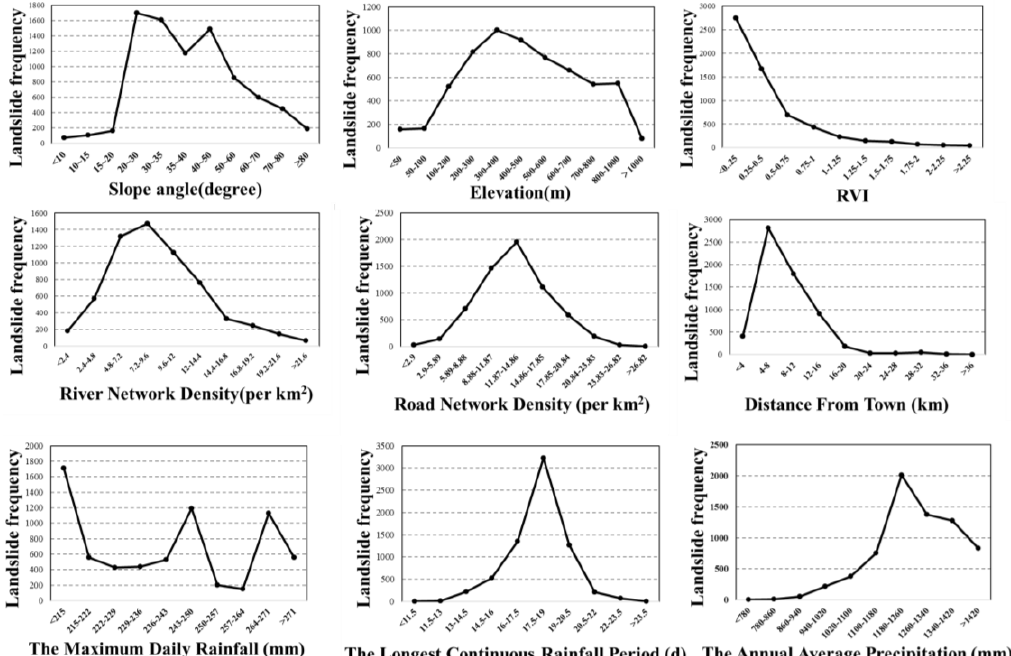
Figure 2. Statistical relationship between influencing factors and landslide